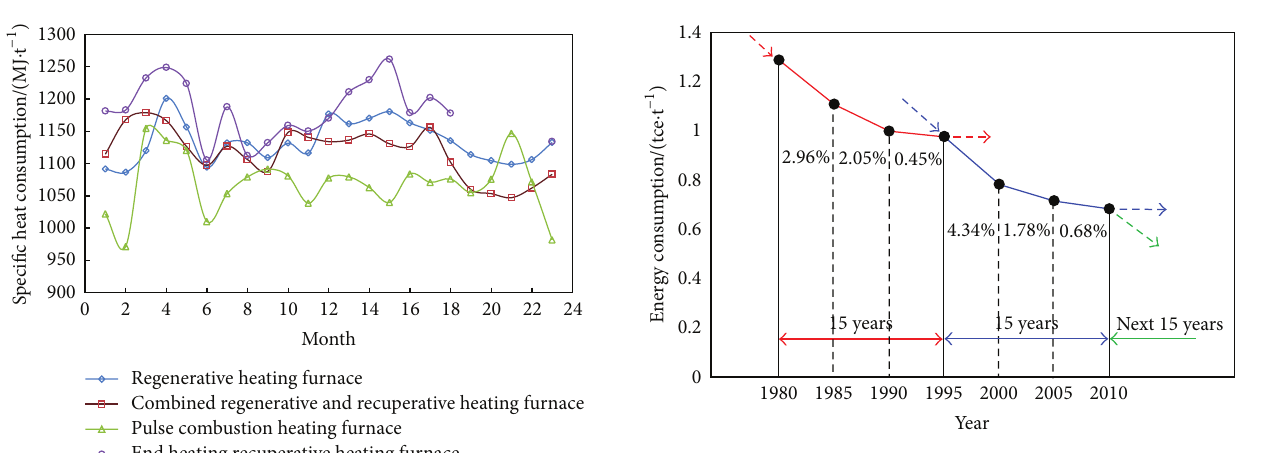
Figure 5: Change trend of energy consumption per ton of crude steel of